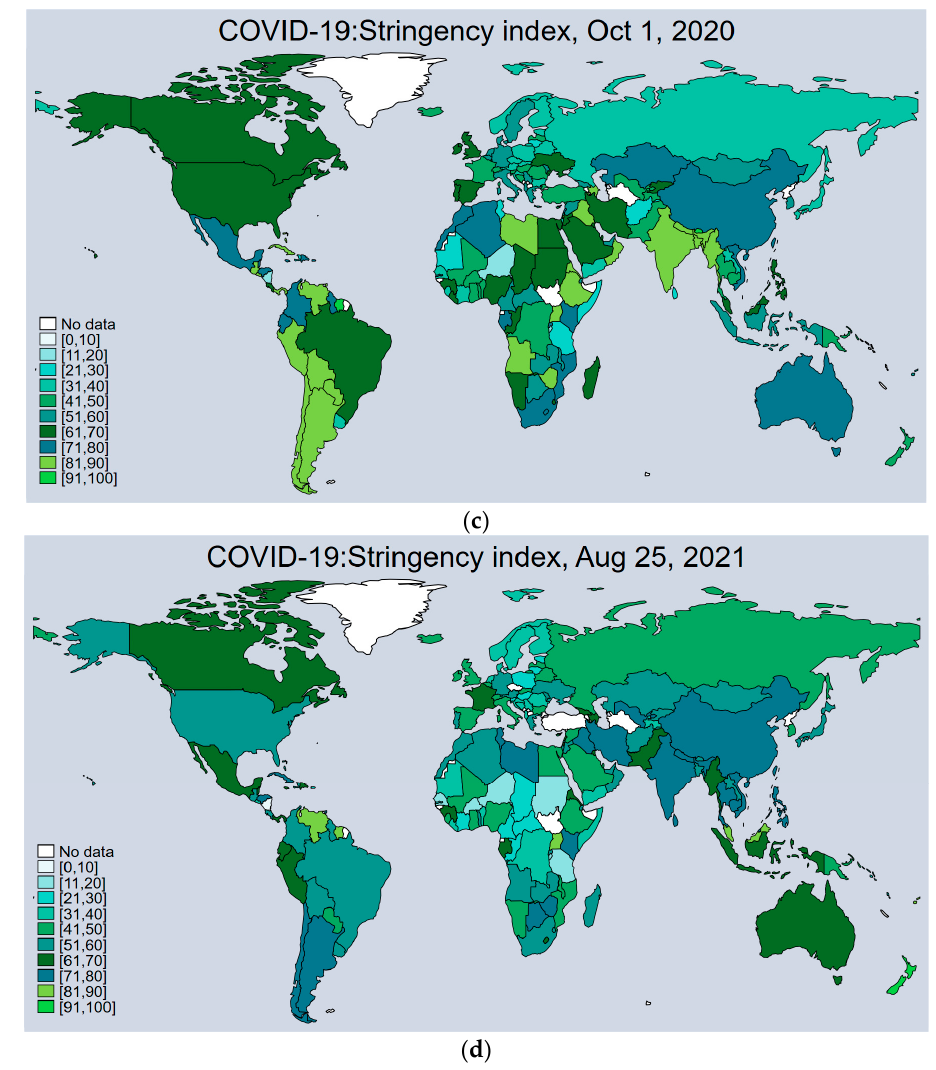
Figure 1. Global GRSI distributions by country separately on ( a ) 22 January 2020; ( b ) 11 March 2020; ( c ) 1 October 2020; ( d ) 25 August 2021. Data Source: Oxford COVID-19 Government Response Tracker, Blavatnik School of Government.